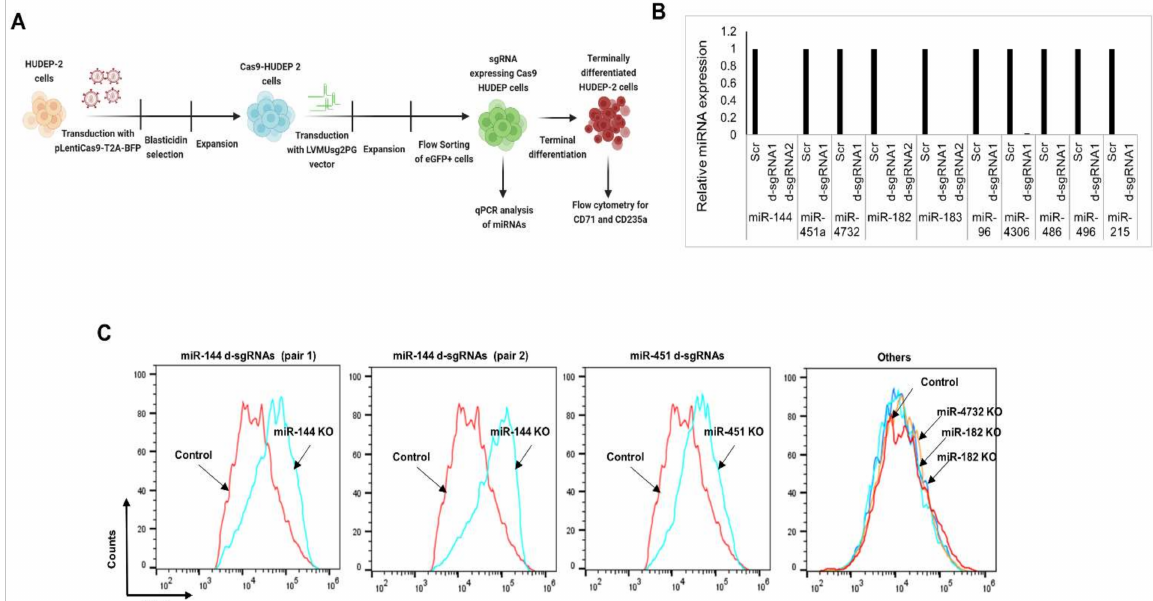
Figure 5. CRISPR-Cas9 editing of miRNAs ( A ) Diagrammatic representation of the CRISPR-Cas9 based editing of miRNAs in HUDEP-2 cells. Cas9-HUDEP2 cells were generated by transduction with pLentiCas9-T2A-BFP lentiviruses, followed by blasticidin selection. The Cas9-HUDEP2 cells were transduced with LVMUsg2PG viruses to express d-sgRNAs that target the miRNAs. The transduced eGFP+ cells were flow-sorted for miRNA knockdown analysis and were terminally differentiated for flow cytometry analysis of CD71 and CD235a expression. ( B ) Real-time PCR analysis of miRNA expression in the Cas9-HUDEP2 cells transduced with LVMUsg2PG lentiviruses that express d-sgRNAs to target the miRNA genes. Scr: scrambled gRNA. d-sgRNA: dual sgRNA. ( C ) Flow cytometry analysis of CD71 expression in the differentiated Cas9-HUDEP-2 after miRNA editing. The results of miRNA-144 KO (with two d-sgRNA pairs) and miR-451 KO (with one d-sgRNA pair) that showed a significant difference in CD71 expression are shown separately from the KO of other miRNAs, miR-4732 (with two pairs of d-sgRNAs), and miR-182 (with one pair of d-sgRNAs). The results for the KO of miR-215, miR-496, miR-486, and miR-4306 are shown in Supplementary Figure